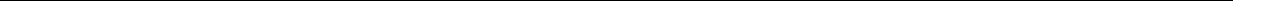
Fig. 4 Bump shifting in the P-ring. a – f Same as Figs. 3a – f. Like the C-ring circuit, the P-ring circuit was able to a develop an activity bump in response to a visual cue; b to maintain only one bump when presented with two cues (indicated by the red ticks ); and c to follow the moving visual cue. However, the bump was less stable than that of the C-ring, as indicated by the occasional drift ( a , b ), by the larger variability in the bump deviation ( d ) and by the wider bump width e . In d and e , the data of the P-ring ( black ) are displayed together with those of the C-ring ( gray , from Figs. 3d, e) for comparison. The error bars indicate the within-trial s.d. f The most distinct difference between the two rings was in their responses to the simulated body rotation in the dark. The activity bump shifted in the P-ring circuit but not in the C-ring circuit (Fig. 3f). g The trial-averaged moving speed of the bump was positively correlated with the strength of the unilateral input to PB. The error bars indicate s.d., while the straight line is the linear regression of the data points. h Left : The PB developed two activity bumps ( gray bars , trial-averaged fi ring rate of the PEN neurons that innervate the corresponding PB regions) of the same height in response to the visual input. Right : The model predicted asymmetric bumps ( gray bars ) in the PB during horizontal body rotation in darkness due to unilateral input to the PB. The black curves in both panels depict the Gaussian fi t to the activity bumps. The x -axis represents the EB region index relative to the peak of the bump on each